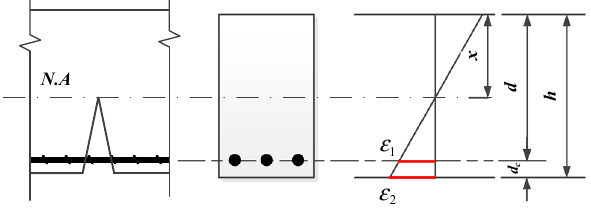
Fig. 2 Definition of the strain gradient amplification